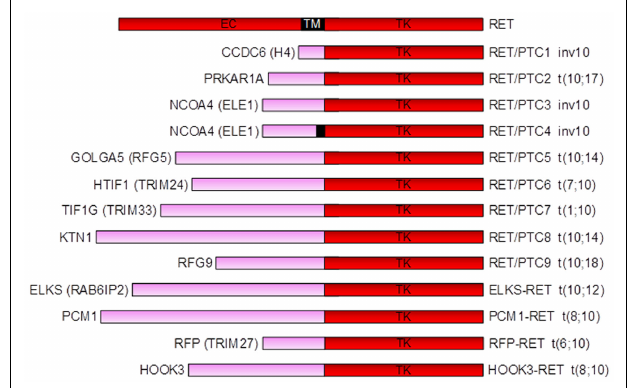
FIGURE 3 | Schematic drawing of RET/PTC variants. At least 13 RET/PTC variants have been reported to date, that differ according to the 5 (cid:2) partner gene involved in the rearrangement.